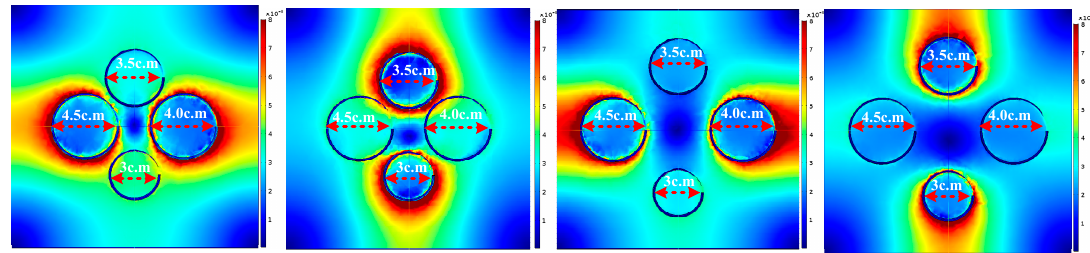
Figure 11. Magnetic field Intensity of Selective Power Transfer with compensation.